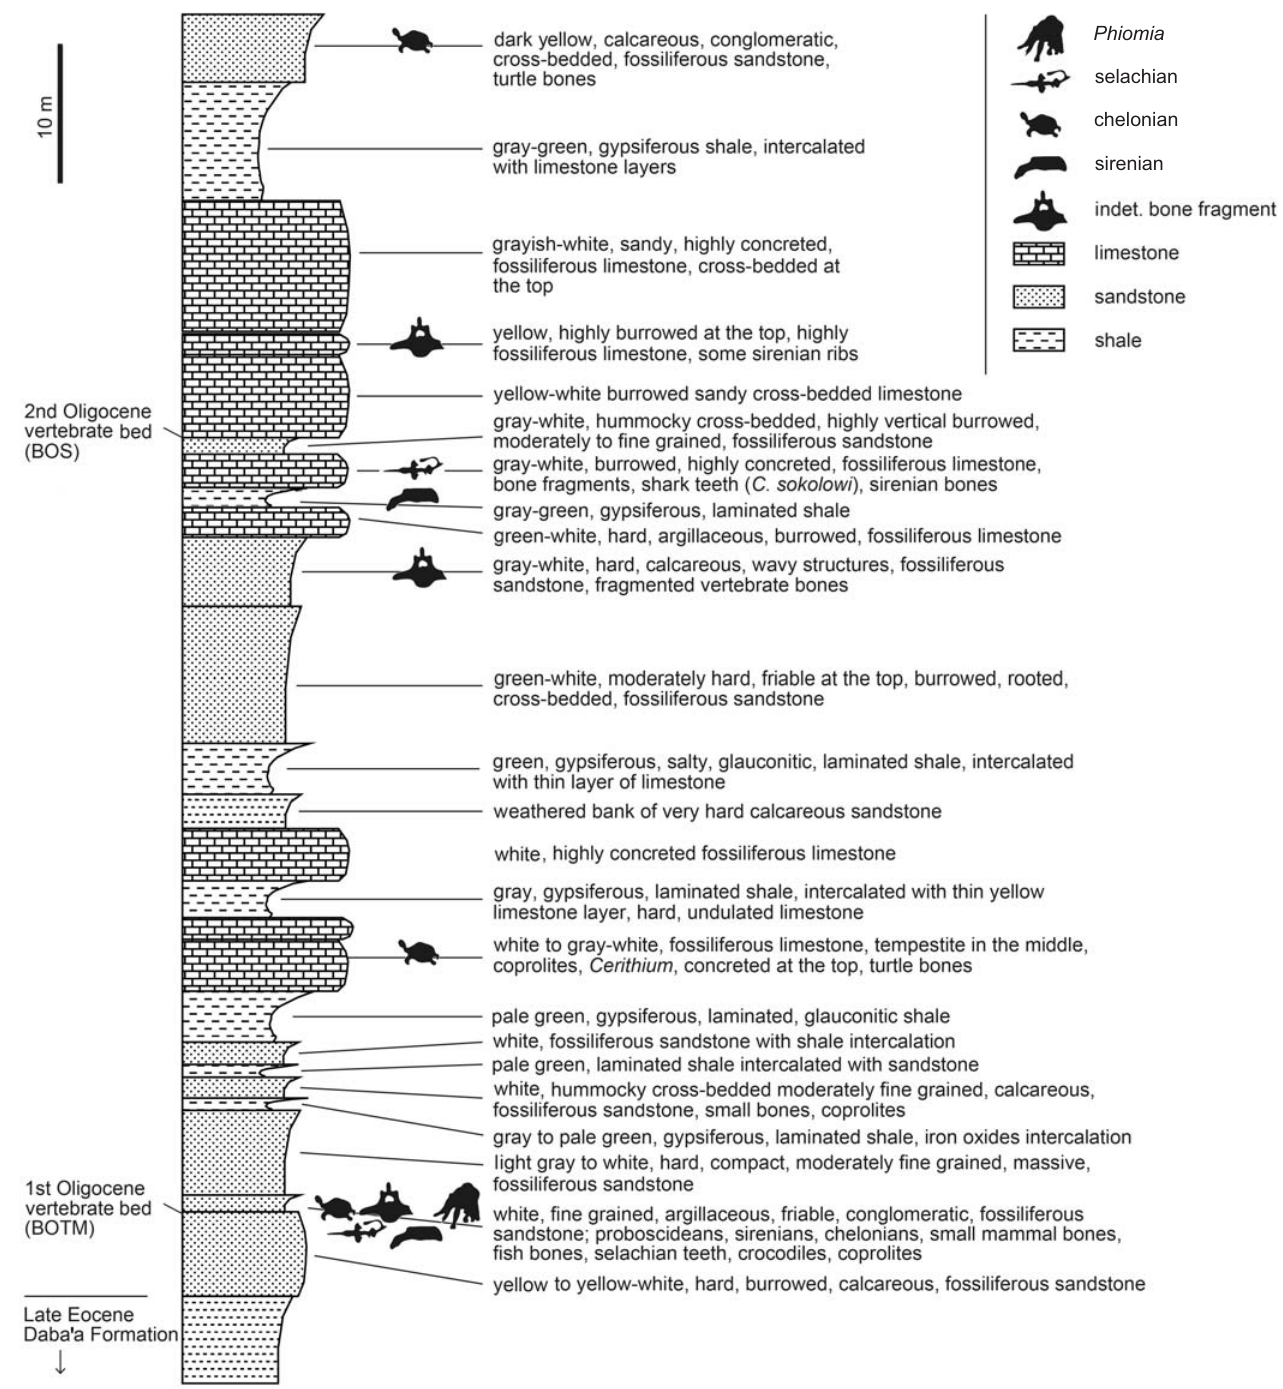
Fig. 1. Stratigraphic section of the Oligocene sediments at Minqar Tibaghbagh, Qattara Depression, Egypt. BOTM and BOS are indicated on the left of the